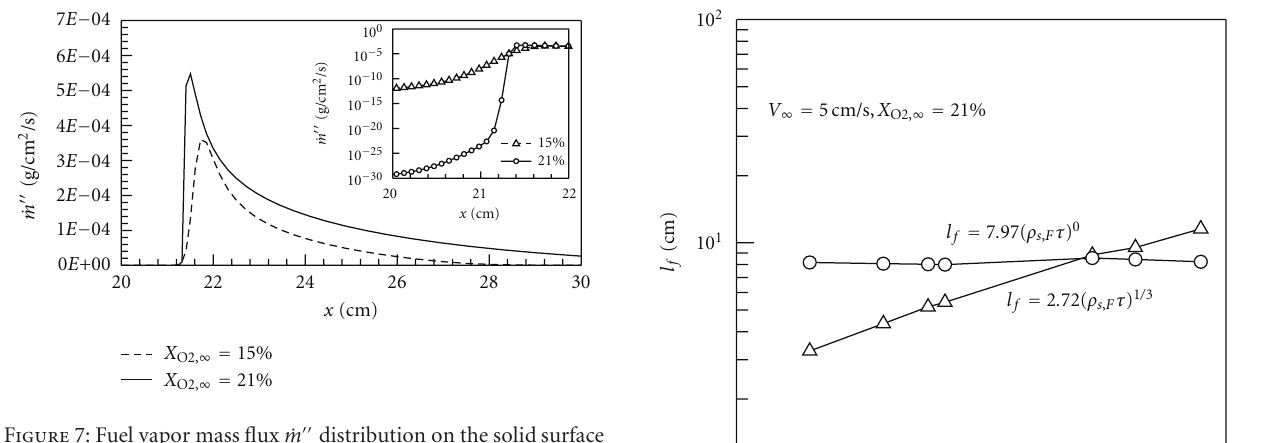
Figure 7: Fuel vapor mass flux ˙ m (cid:3)(cid:3) distribution on the solid surface changes when the flame approaches the extinction limit for the first- order pyrolysis cases. In the inset, a log-scale ordinate is used.